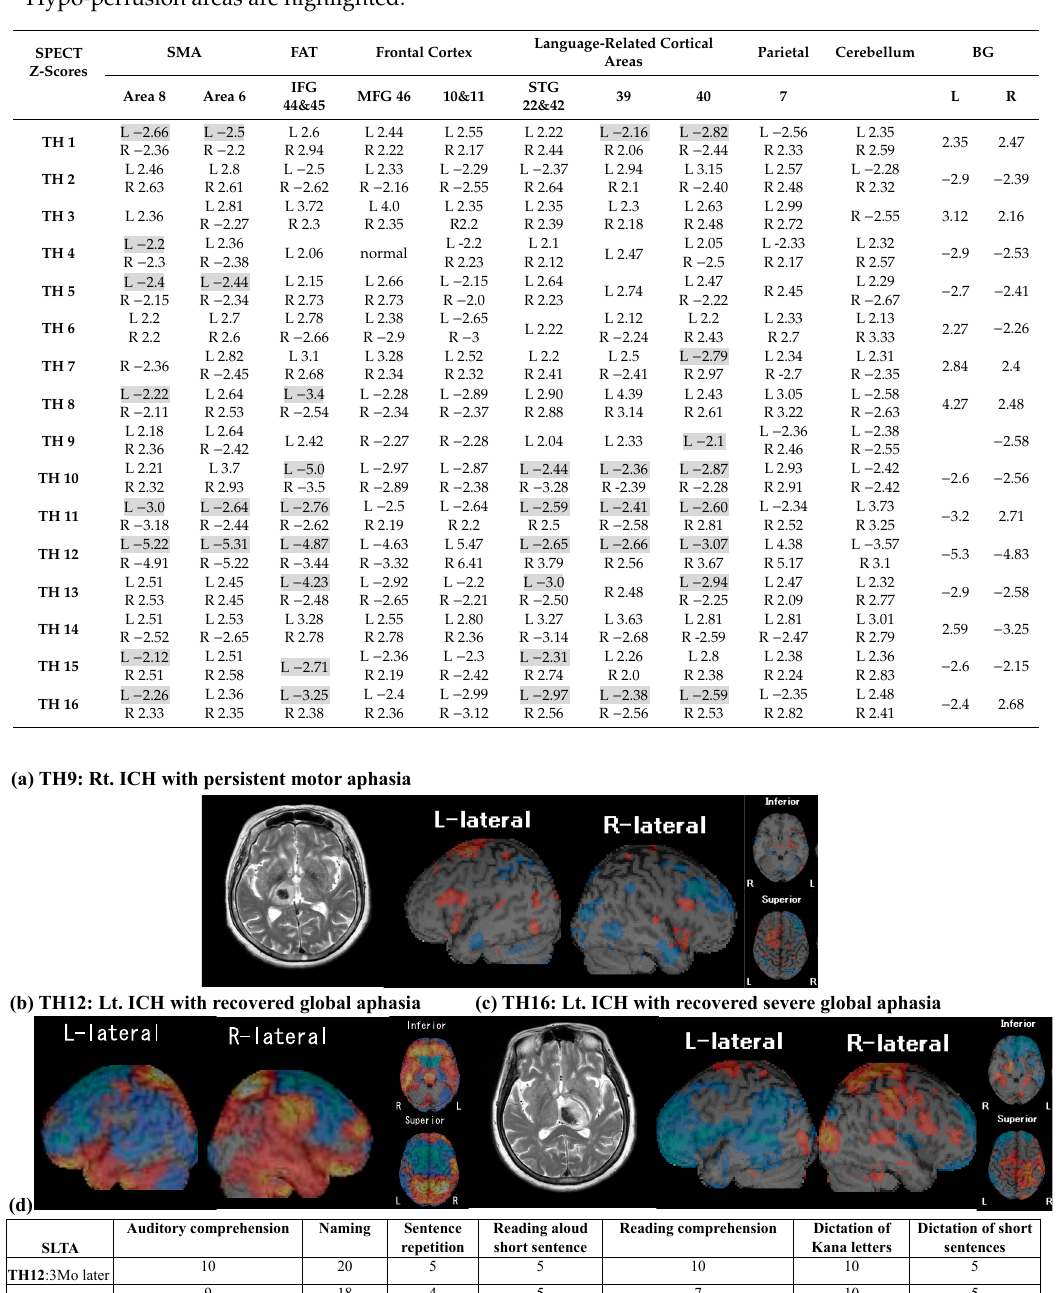
Table 3. SPECT Z-scores in Brodmann areas. WNL: within normal limit, namely, scores within ± 2SD. Hypo-perfusion areas are highlighted.